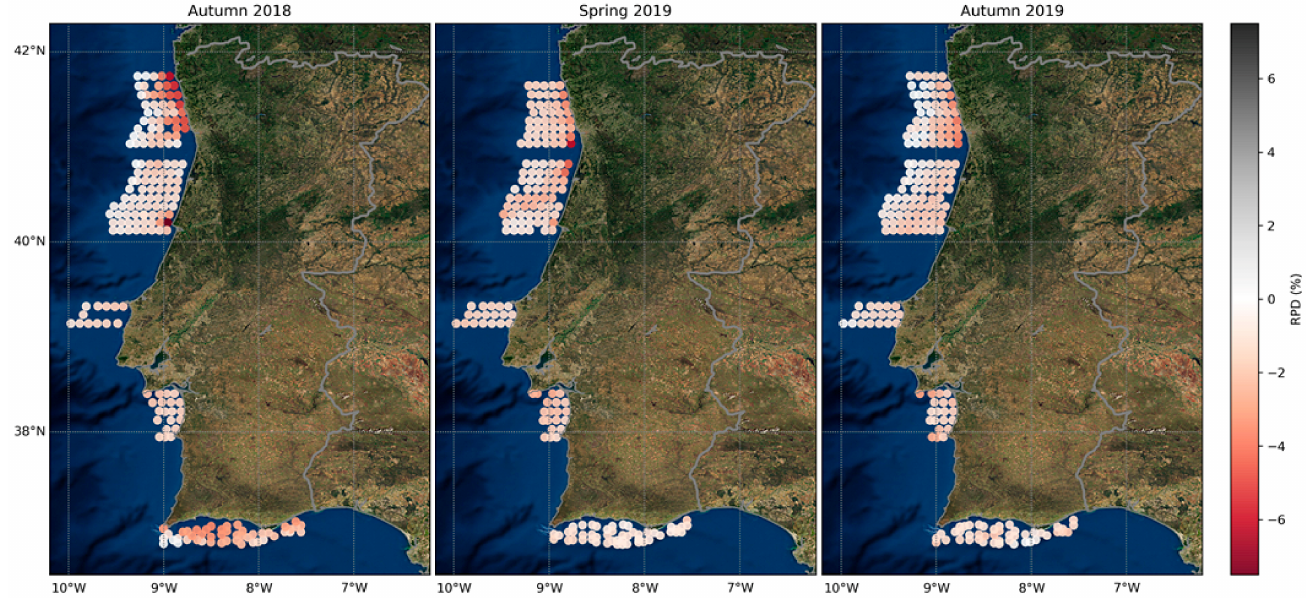
Figure 6. RPD (%) values of each model matchup along the Portuguese coast during the three cruises. However, in some of the points sampled near shore during that cruise, a tendency for high overestimations was observed. On the other hand, the model RPD values